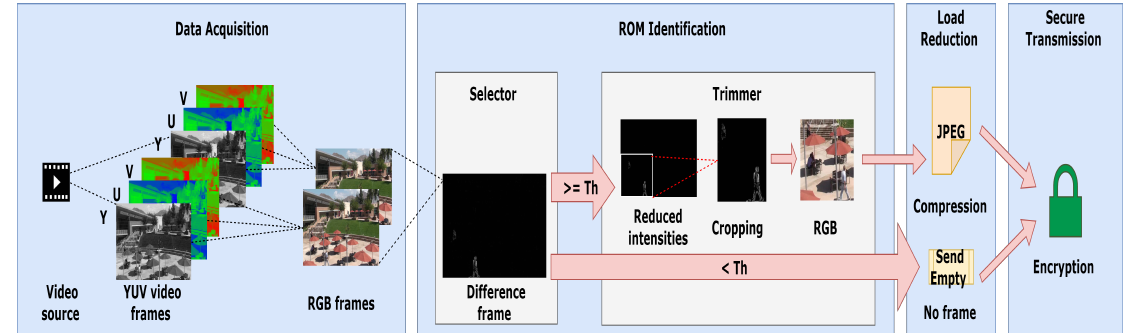
Figure 1. A modular representation of the